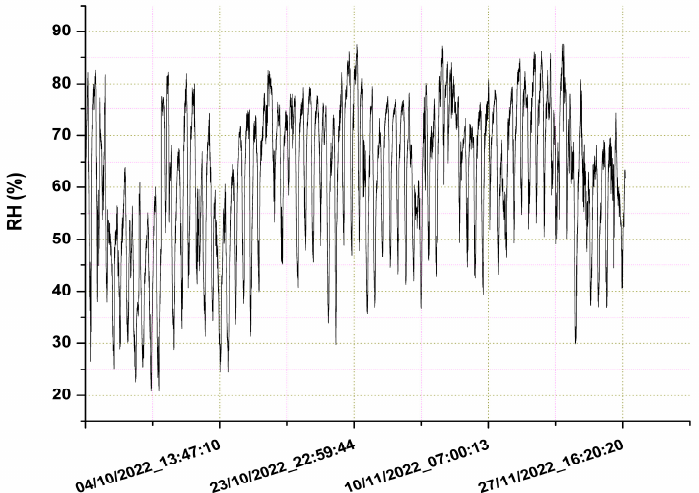
Figure 7. Time series of the relative humidity registered during the experiment.